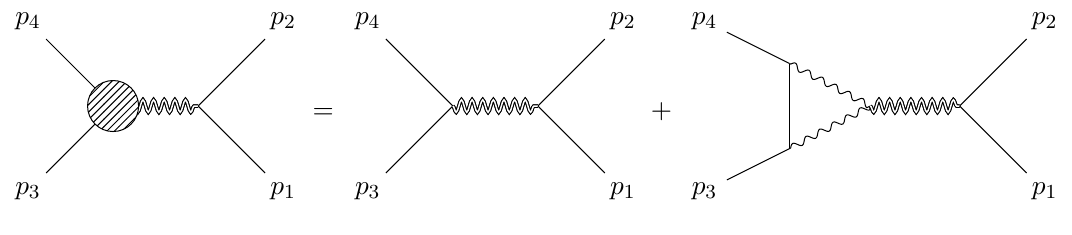
Figure 4 . Diagrams contributing to the classical potential at order G and (cid:11)